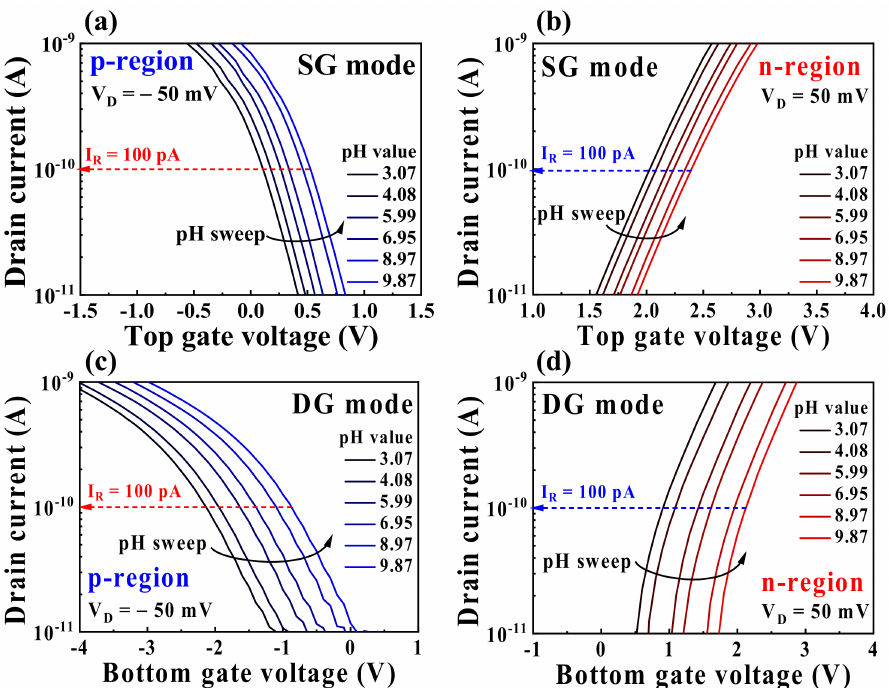
Figure 5. Transfer characteristic (V G –I D ) curves of the ambipolar DG ISFET for different pH buffer solutions. SG mode sensing in the ( a ) p region and ( b ) n region. DG mode sensing in the ( c ) p region and ( d ) n region.